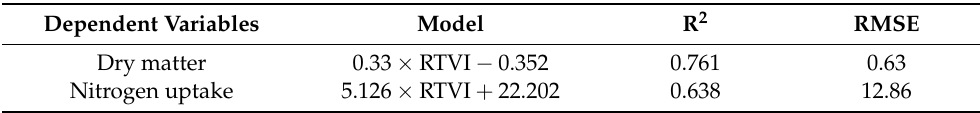
Table 6. Mathematical linear models of dry matter and nitrogen uptake and values of R 2 and RMSE by general